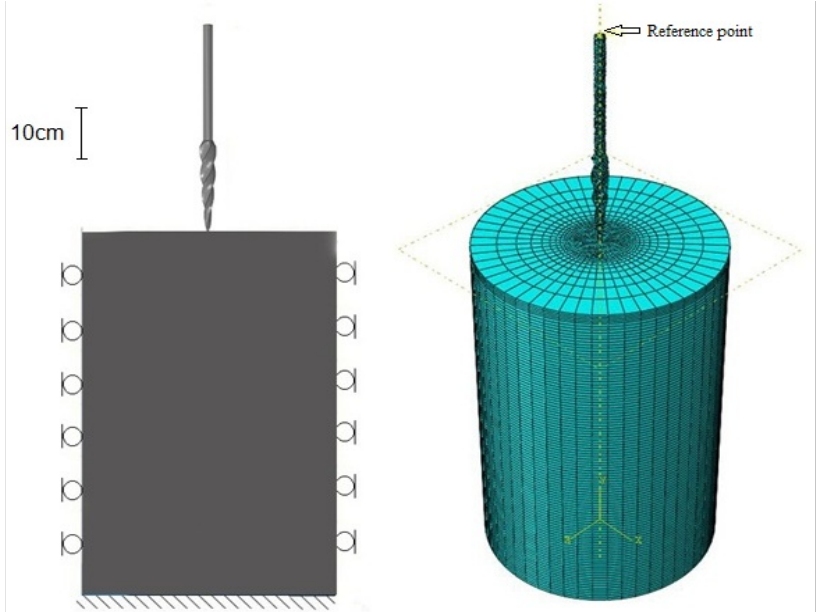
Figure 6. Schematic view of the finite element model with mesh and boundary conditions in Abaqus. The figure scale is indicated.